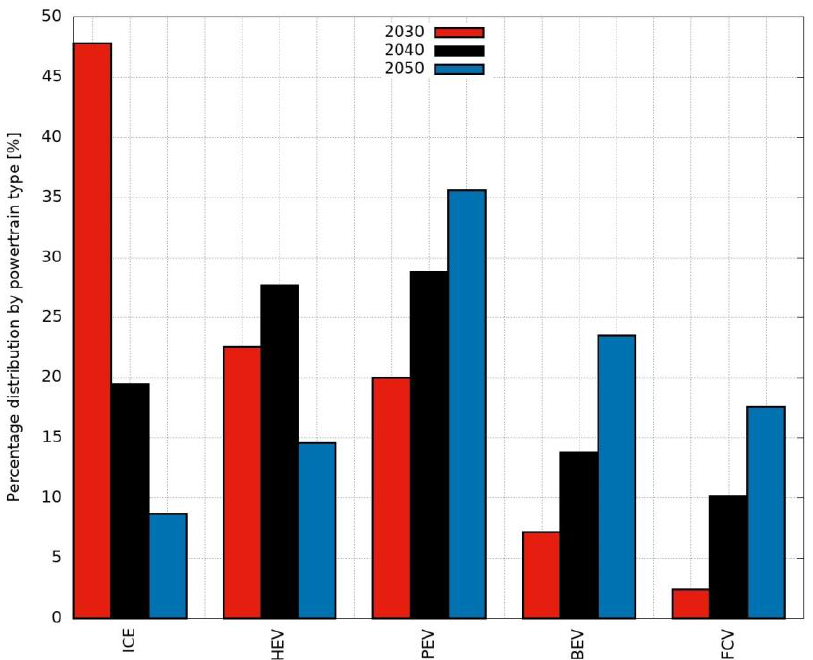
Figure 10. Prevision of the percentage distribution by powertrain type of passenger vehicles in Italy up to 2050 [17,18]. Table 5. Current and upcoming percentage deployment of passenger vehicles by powertrain/fuel type in Italy (own analysis from [19]).